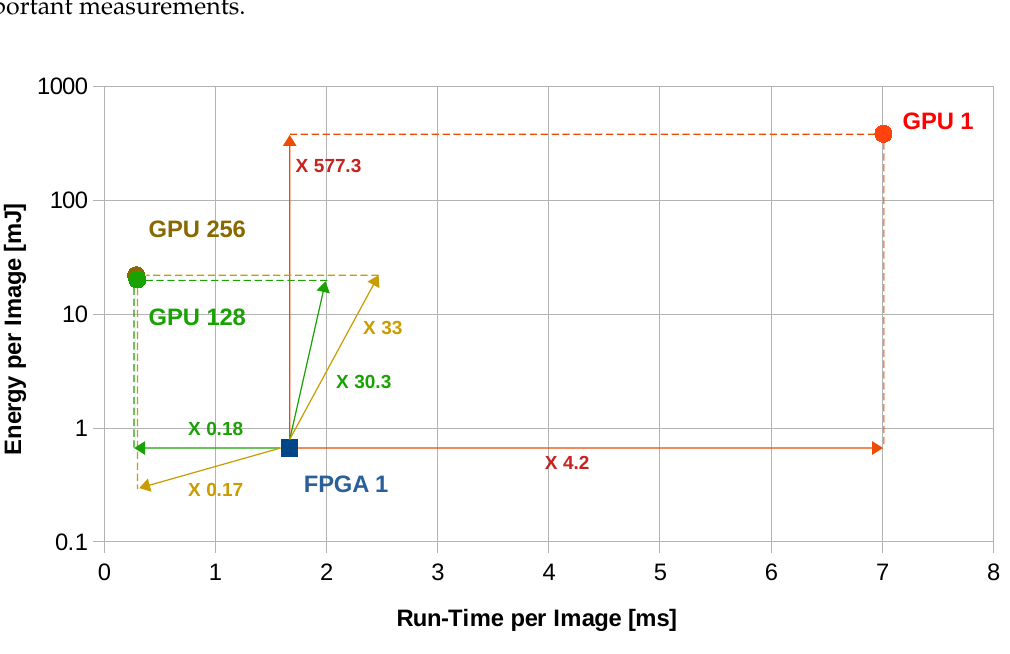
Figure 9. Performance analysis for different batch sizes; FPGA 1 denotes the FPGA implementation performance for batch size 1. Similarly, GPU1, GPU128 and GPU256 denote the GPU implementation performance for batch sizes 1, 128 and 256, respectively. For comparison purposes, we have shown the factors by which the performance differs for different implementations (the numbers on the